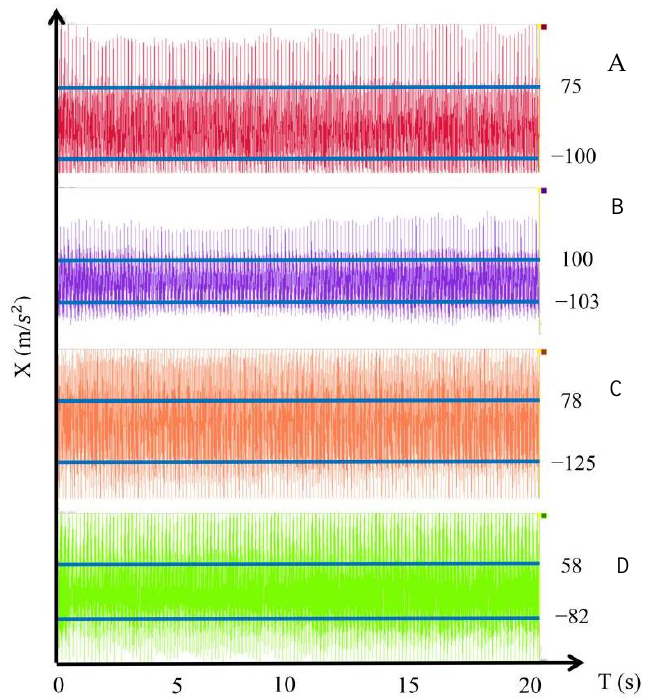
Figure 22. Vibration response of the optimized plate.